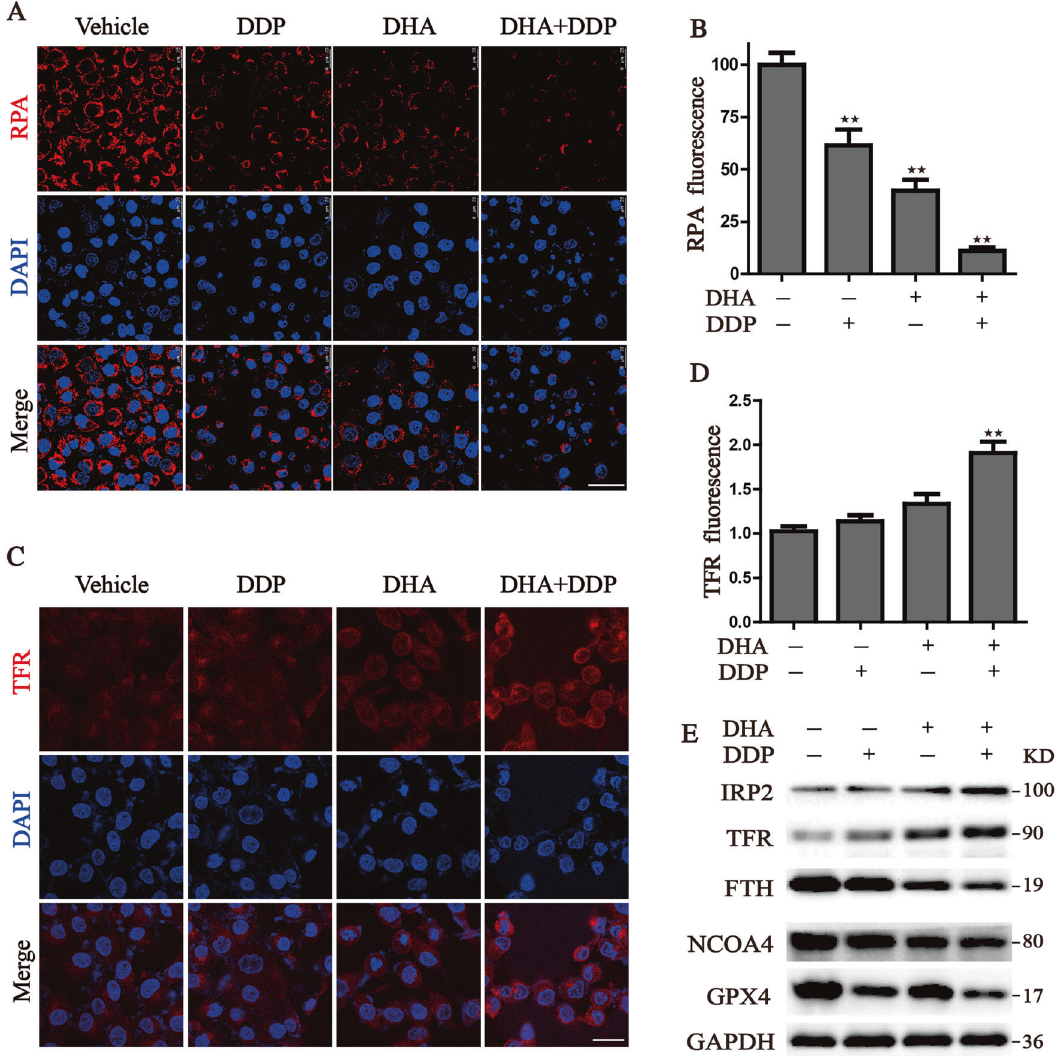
Fig. 5 Iron accumulation in pancreatic cancer cells induced by the combination treatment of DHA and DDP. A , B Intracellular Fe 2 + was measured by the staining of RPA and photographed by the confocal microscope after indicated treatment. Scale bars: 50 μ m. C , D Detection of cell surface TFR levels by immuno fl uorescence staining of PANC1 cells after indicated treatment. E The expression of iron metabolism proteins in DHA- and DDP-treated cells, which was determined by western blot assay (values represented mean ± SD. ★ P < 0.05, ★★ P < 0.01 versus